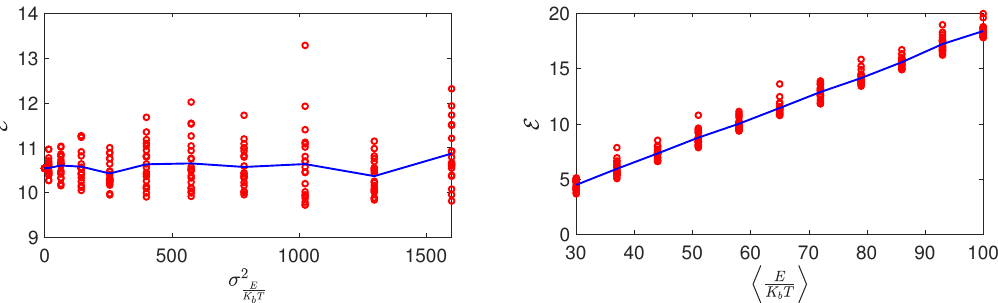
Figure 13. Extra-toughness behavior E in terms of the stochastic distribution of sacrificial bond rupture energies. In both examples, we considered a chain with s = 4 and n = 2. On the left panel, we assumed an independent exponential distribution of the rupture energies with a fixed average value and varying variance. Conversely, on the right panel, we assumed an independent exponential distribution of the rupture energies with fixed variance and varying average value (see details in the main text). The red circles represent the single results (Monte Carlo realizations) and the blue lines the corresponding average values. The other parameters are given by N = 20, h / k = 1, and d / (cid:96) =